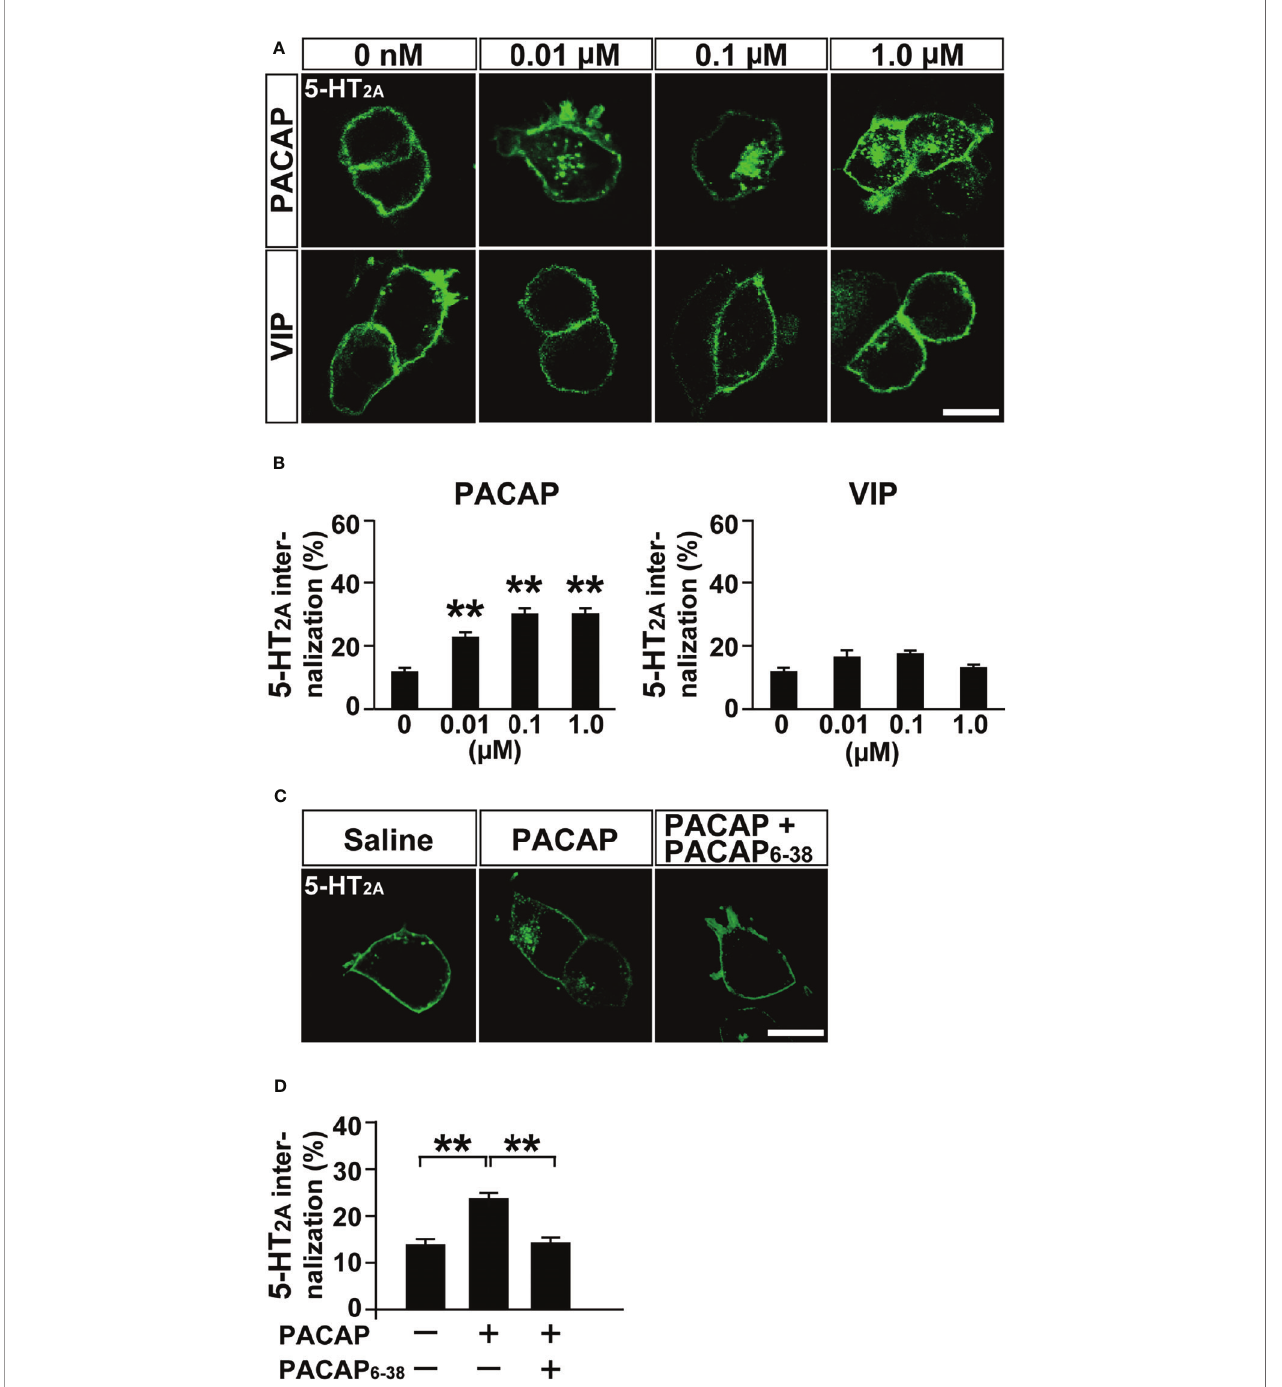
FIGURE 2 | PACAP induces 5-HT 2A internalization via PAC1 in HEK293T cells. (A) Representative images of HEK293T cells transfected with HaloTag 5-HT 2A . The cells were labeled with Alexa Fluor 488 HaloTag membrane impermeable ligand for 15 min and then treated with the indicated concentrations of PACAP or VIP for 30 min. Scale bar, 10 m m. (B) Quanti fi cation of 5-HT 2A internalization. Values are the mean ± SEM of 46 – 71 cells obtained from three independent experiments. ** p < 0.01 vs. 0 m M, one-way ANOVA followed by the Tukey-Kramer test. (C) Representative images of HEK293T cells transfected with 5-HT 2A . The cells were pretreated with 2 m M PACAP 6-38 or saline for 30 min, labeled with Alexa Fluor 488 HaloTag membrane impermeable ligand for 15 min and then treated with 100 nM PACAP or saline for 30 min. Scale bar, 10 m m. (D) Quanti fi cation of 5-HT 2A internalization. Values are the mean ± SEM of 80 – 86 cells obtained from three independent experiments. ** p < 0.01, one-way ANOVA followed by the Tukey-Kramer